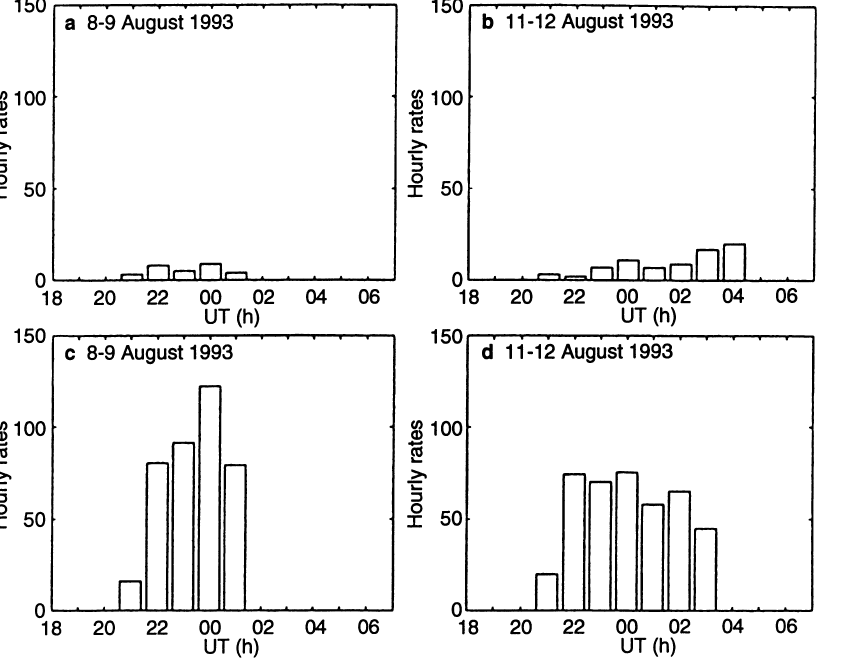
Fig. 6. Hourly rates of the Perseid cam- paign in August 1993. The data are taken simultaneously with the UHF ( a, b ) and the VHF ( c, d ) radars